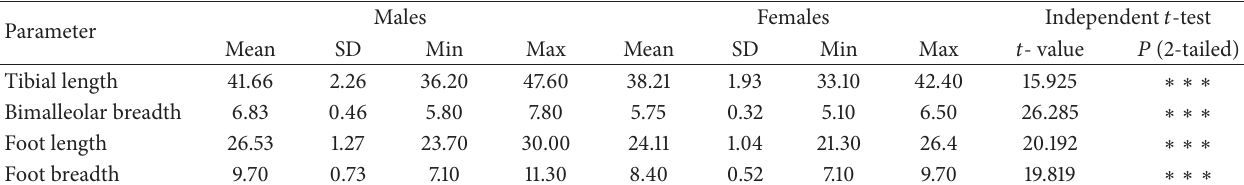
Table 1: Descriptive statistics for lower limb dimensions (in cm) in both sexes. Parameter